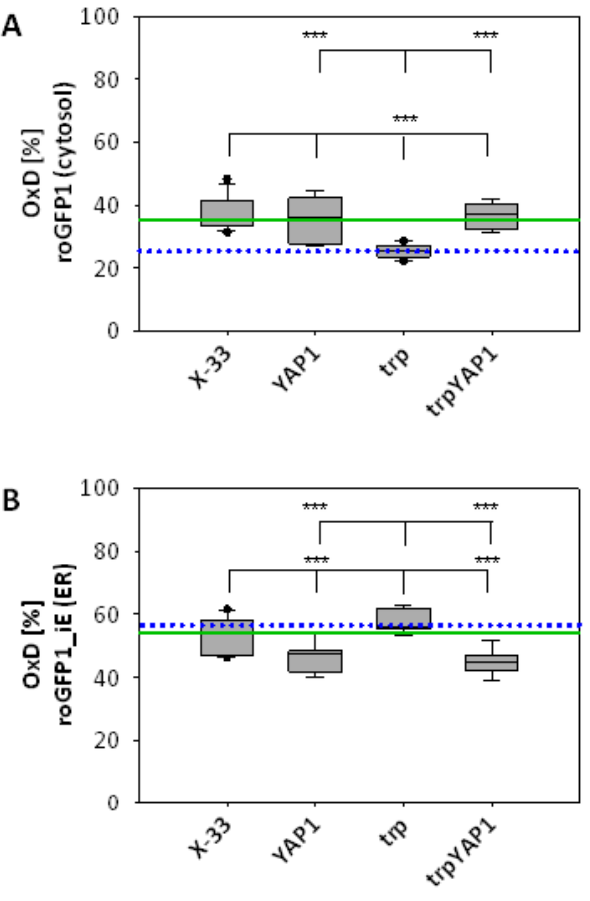
FIGURE 3: YAP1 co-overexpression with trypsinogen reoxidizes the cytosol redox state to the level of the wild type strain, while slightly reducing the ER redox ratio. The OxD obtained with roGFP are represented as Box-and-Whisker plots. Each box is sep- arated into two inter-quartiles by the statistical median as a hori- zontal line in the box. The extreme values extending from the in- ter-quartile at most 1.5 times from the upper or lower inter- quartile are the ‘whiskers’. The green line indicates the median of X-33, the blue dotted line represents the median of the trp strain. (A) Cytosolic redox ratios of the respective strains represented as OxD of roGFP. Statistical significance is indicated as for (B). (B) ER redox ratios of the respective strains represented as OxD of roGFP-iE. *** in the lower row indicate a significant difference to X-33 (P < 0.01). *** in the upper row indicates a significant differ- ence to the trp